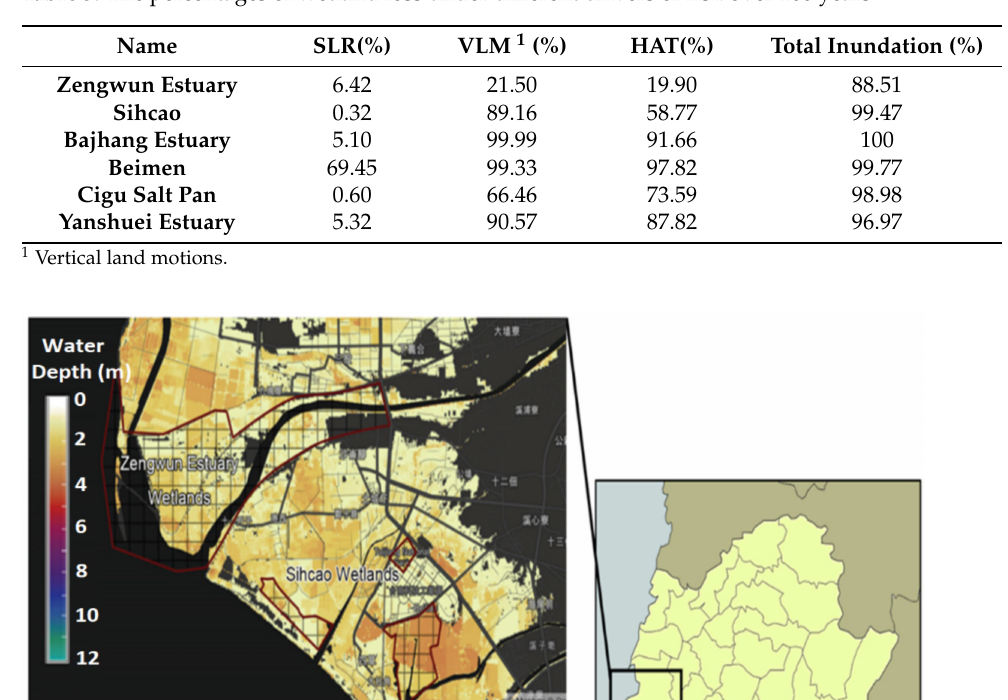
Table 3. The percentages of wetland loss under different drivers of risk over 100 years.